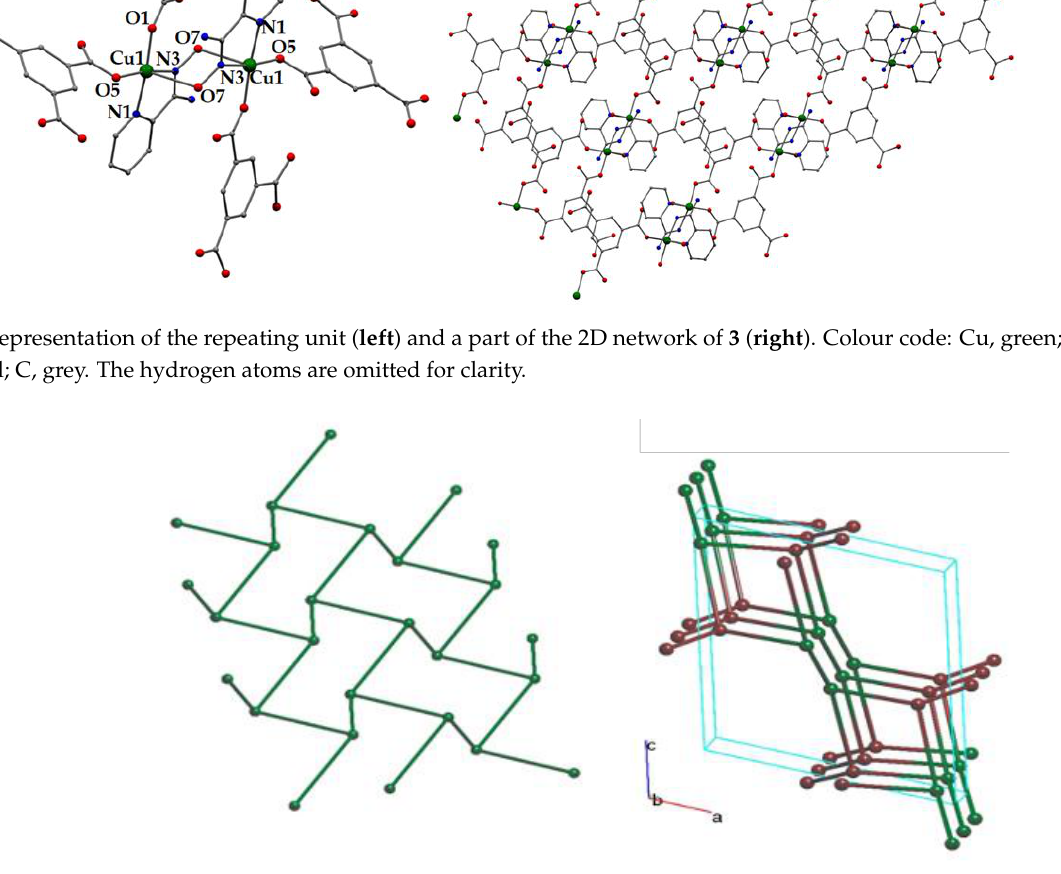
Figure 4. Left: representation of the underlying 3-c net with hcb topology in 3 . Right: representation